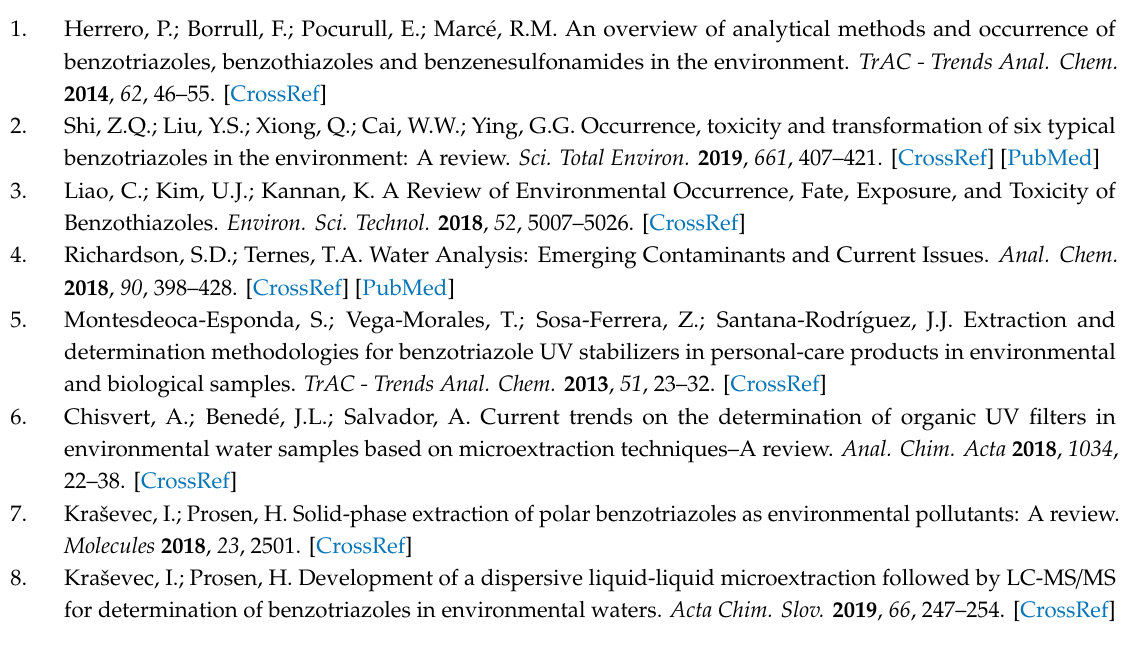
Table S1: chemical properties of the target compounds, Table S2: instrumental results, Table S3: calibration parameters using ultra-pure water; Figure S1: e ff ect of solvent type and sonication time on the microextraction performance; Figure S2: e ff ect of stirring speed on the microextraction performance; Figure S3: e ff ect of MeOH and NaCl addition on the microextraction